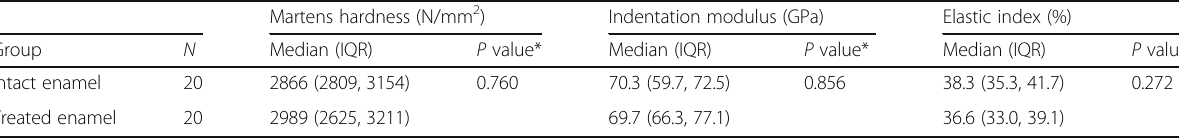
Table 1 Results for the mechanical properties of the analyzed specimen